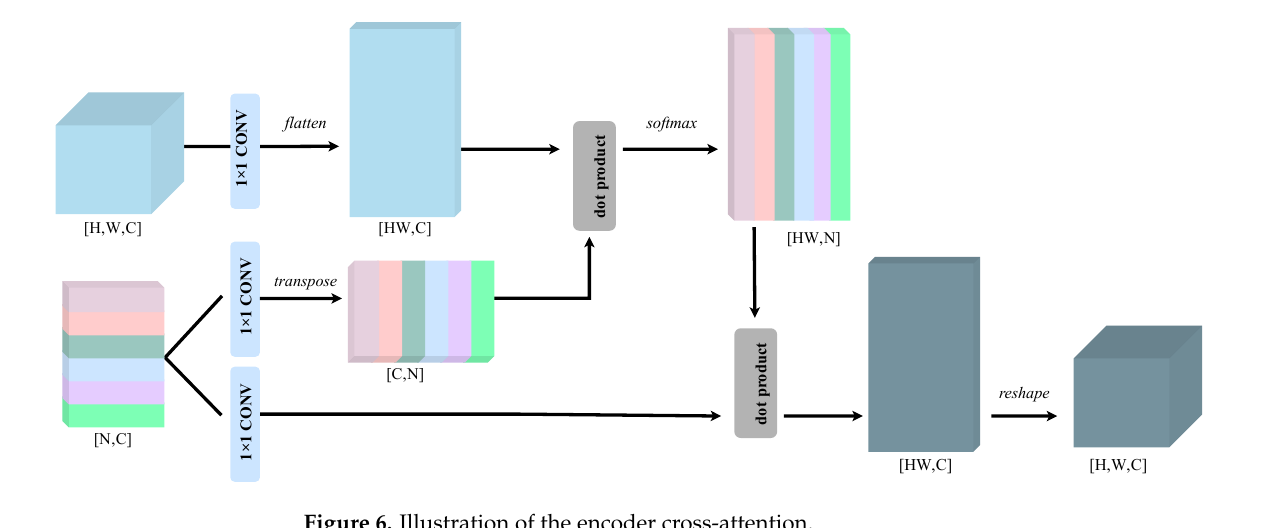
Figure 6. Illustration of the encoder cross-attention.